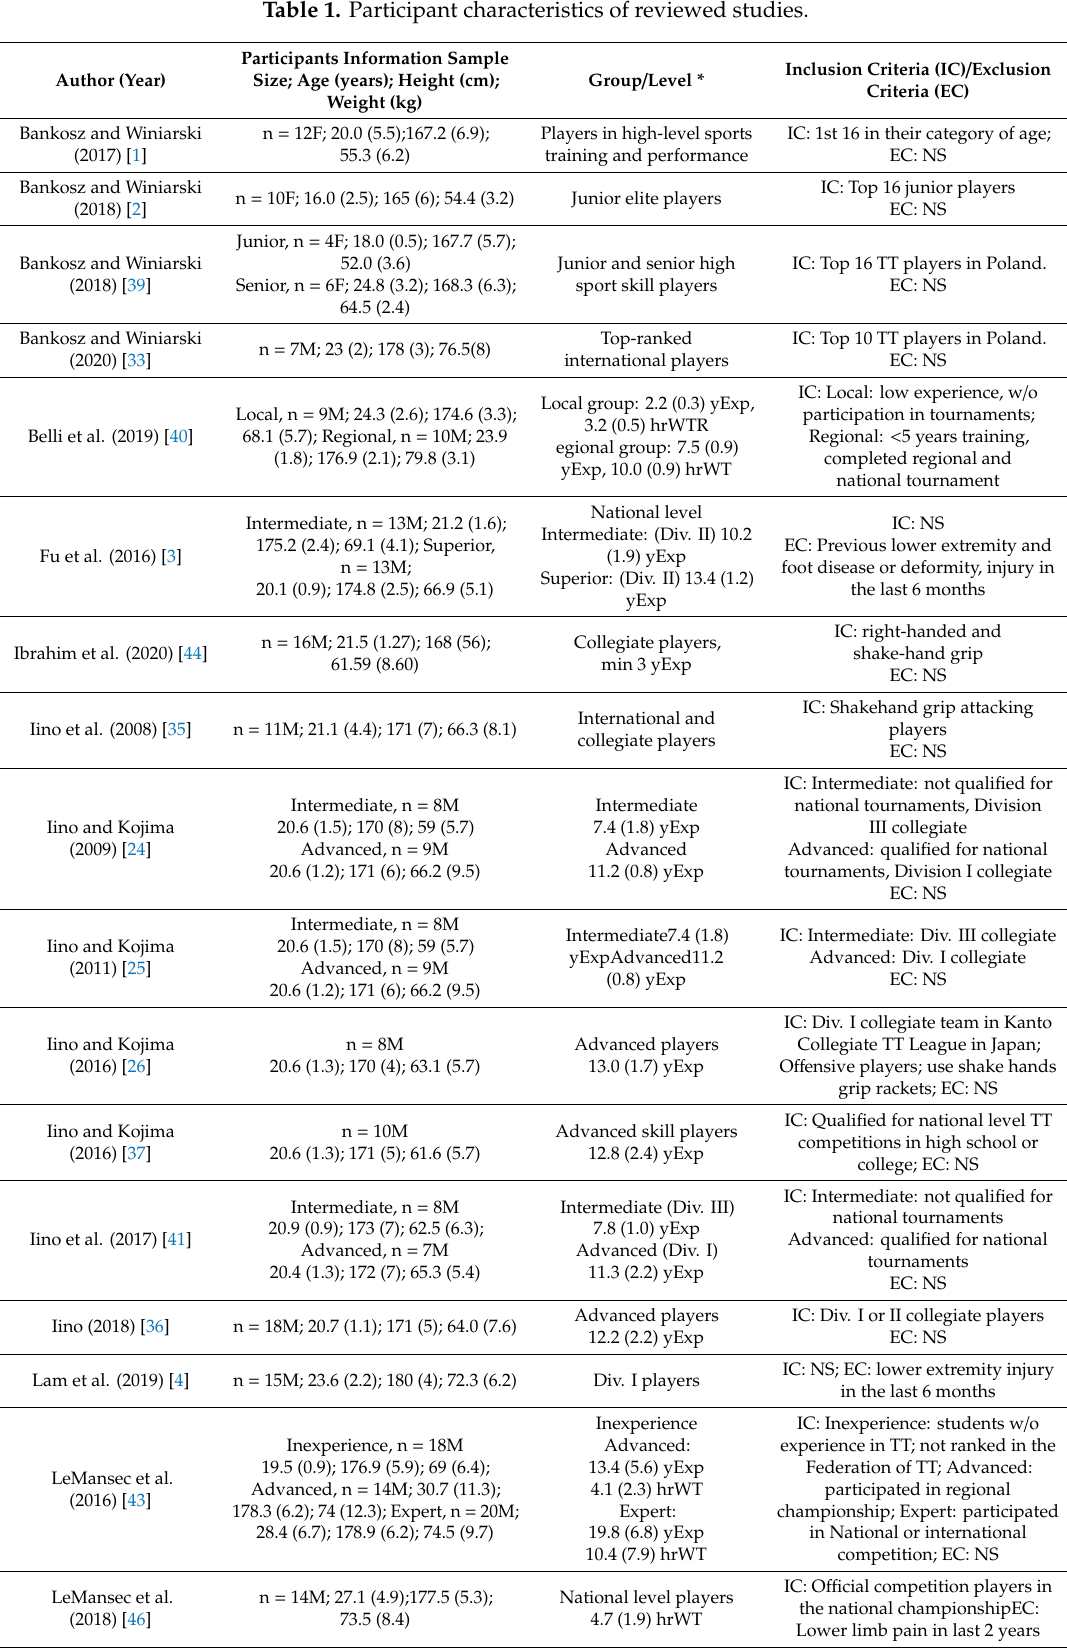
Table 1. Participant characteristics of reviewed